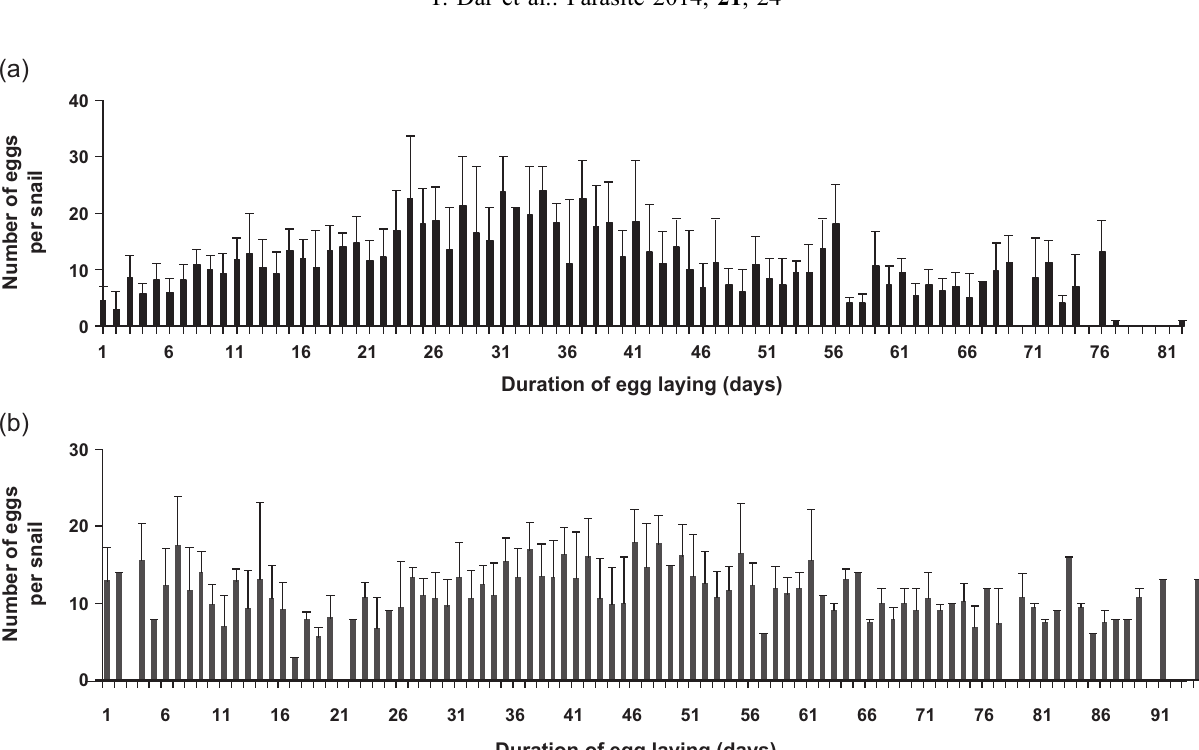
Figure 1. Numerical distribution of eggs per Radix natalensis and per day of the egg-laying period in unexposed controls (a) and the uninfected snails of the exposed group (b).